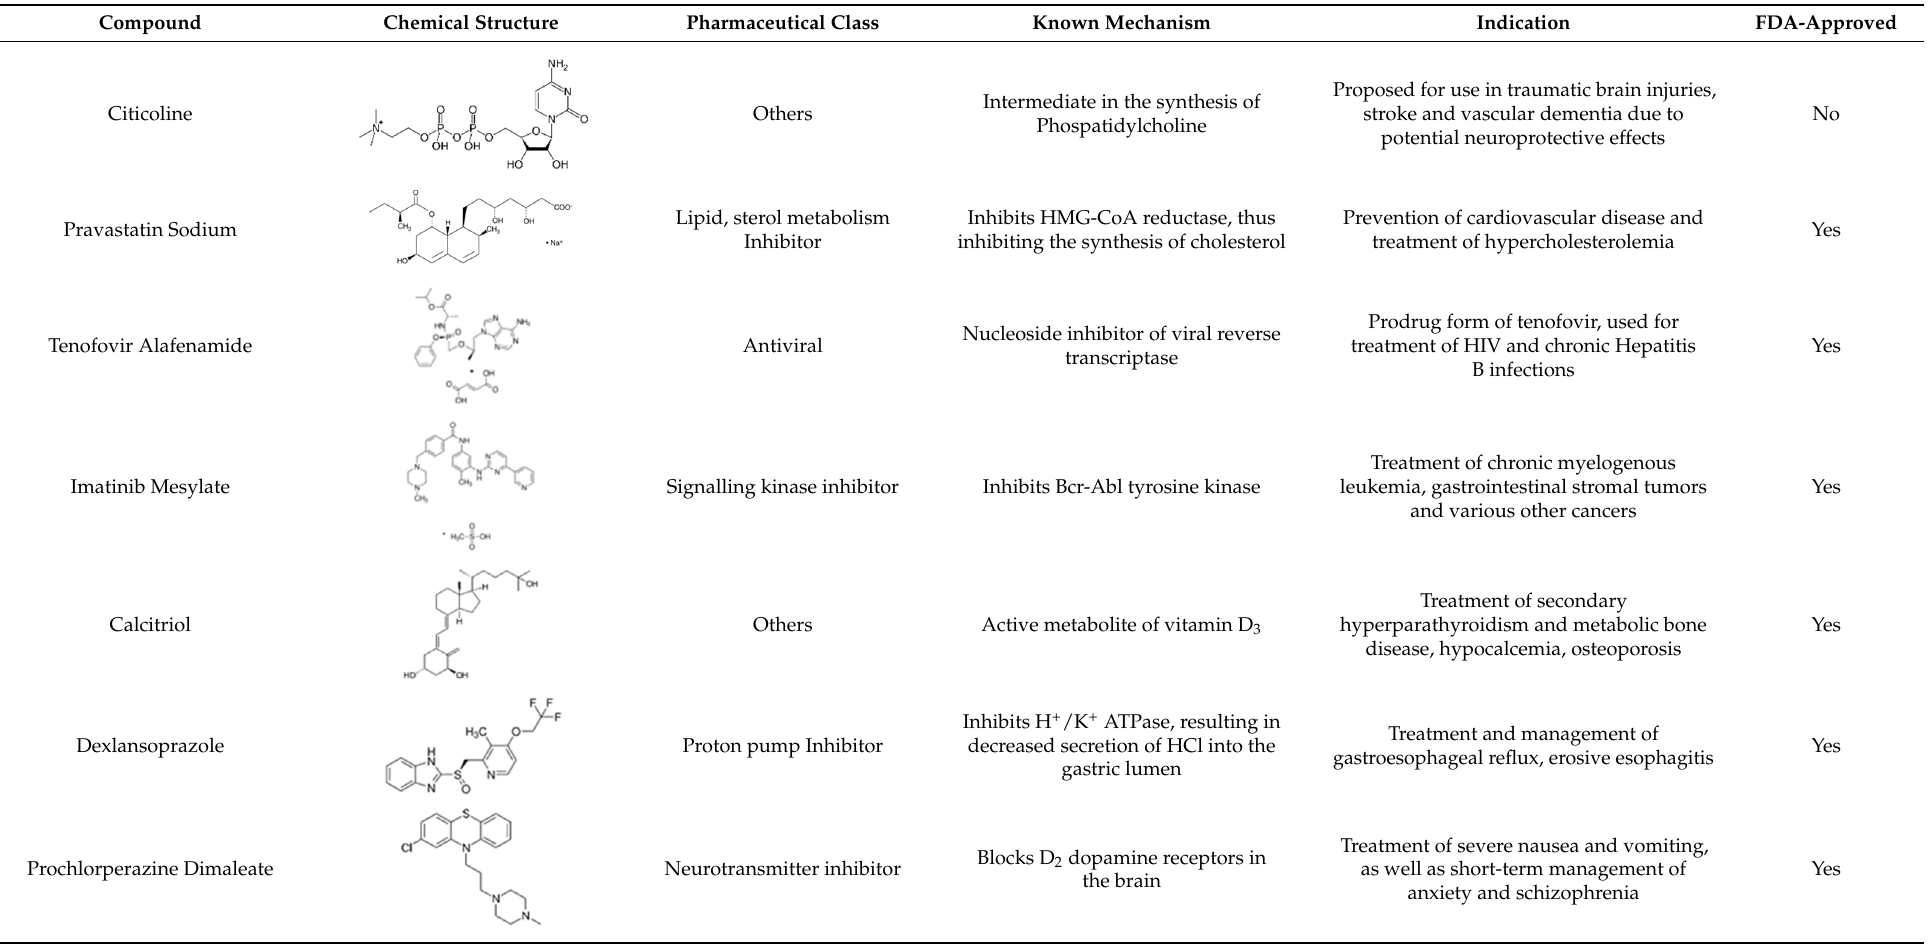
Table 2. Summary of compounds identified from the primary screen that exhibit potential antiviral effects against SARS-CoV-2 infection.